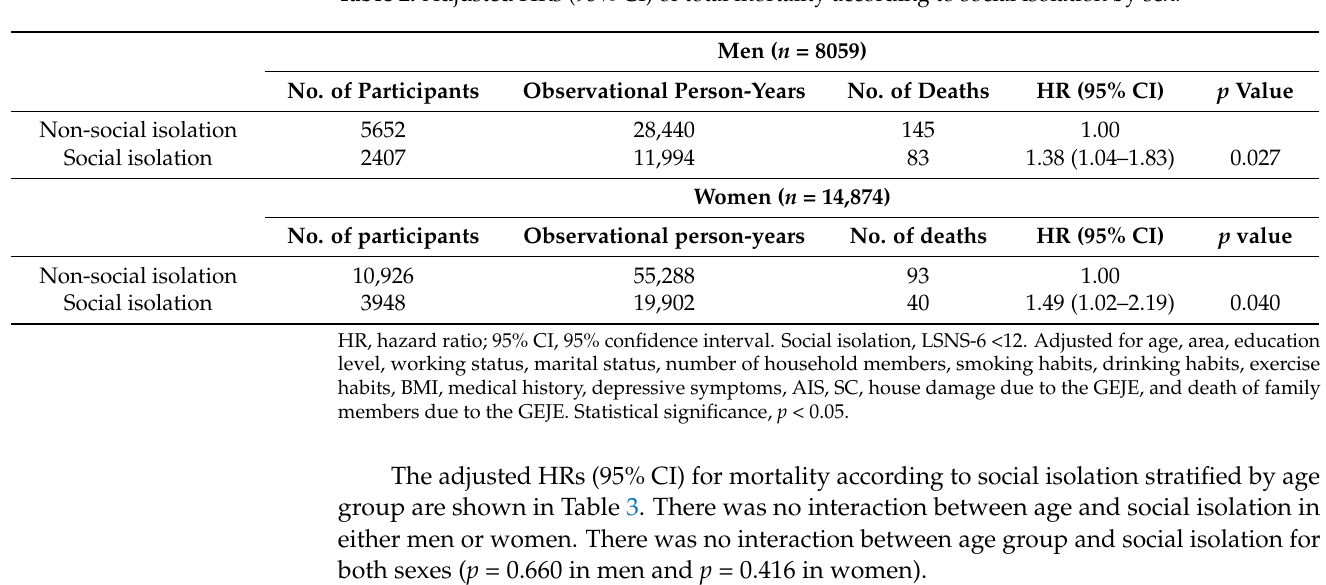
Table 2. Adjusted HRs (95% CI) of total mortality according to social isolation by sex.